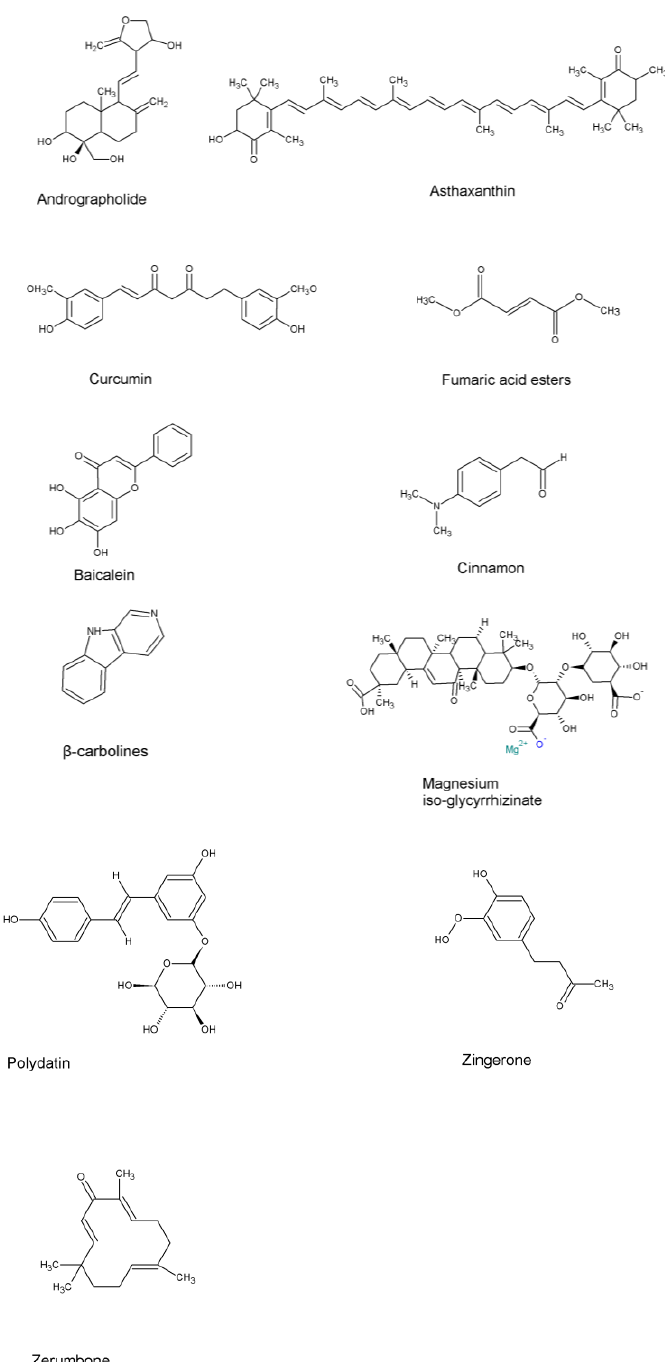
Figure 3. Chemical structures of the natural compounds to be repurposed.